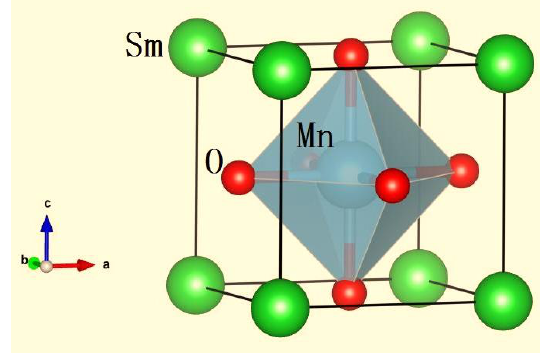
Figure 7. Structure diagram of SmMnO 3.